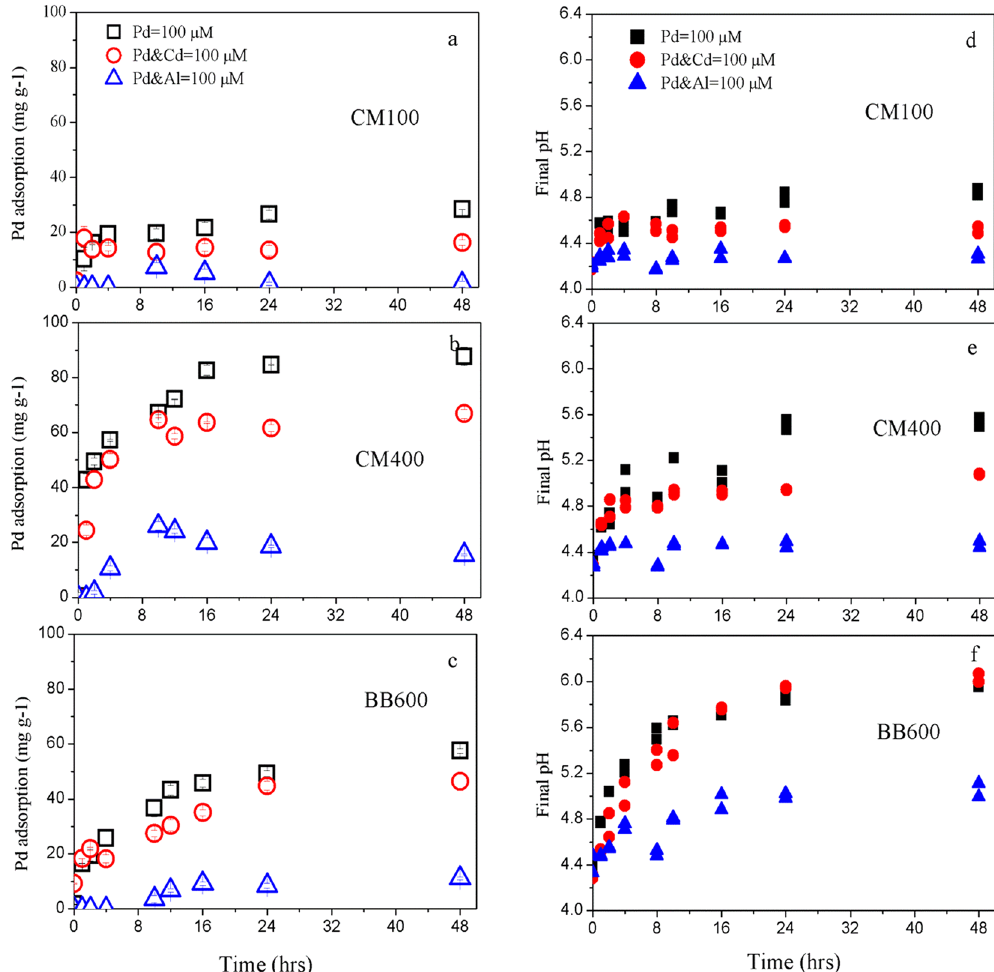
Figure 5. Effect of coexisting Cd and Al on Pb adsorption kinetics onto the cattle manure biochar [CM100 ( a ) and CM400 ( b )] and bamboo biochar [BB600 ( c )], the final pH of the cattle manure biochar [CM100 ( d ) and CM400 ( e )] and bamboo biochar [BB600 ( f )] after adsorption. The numbers in the sample names represent the pyrolysis temperatures.